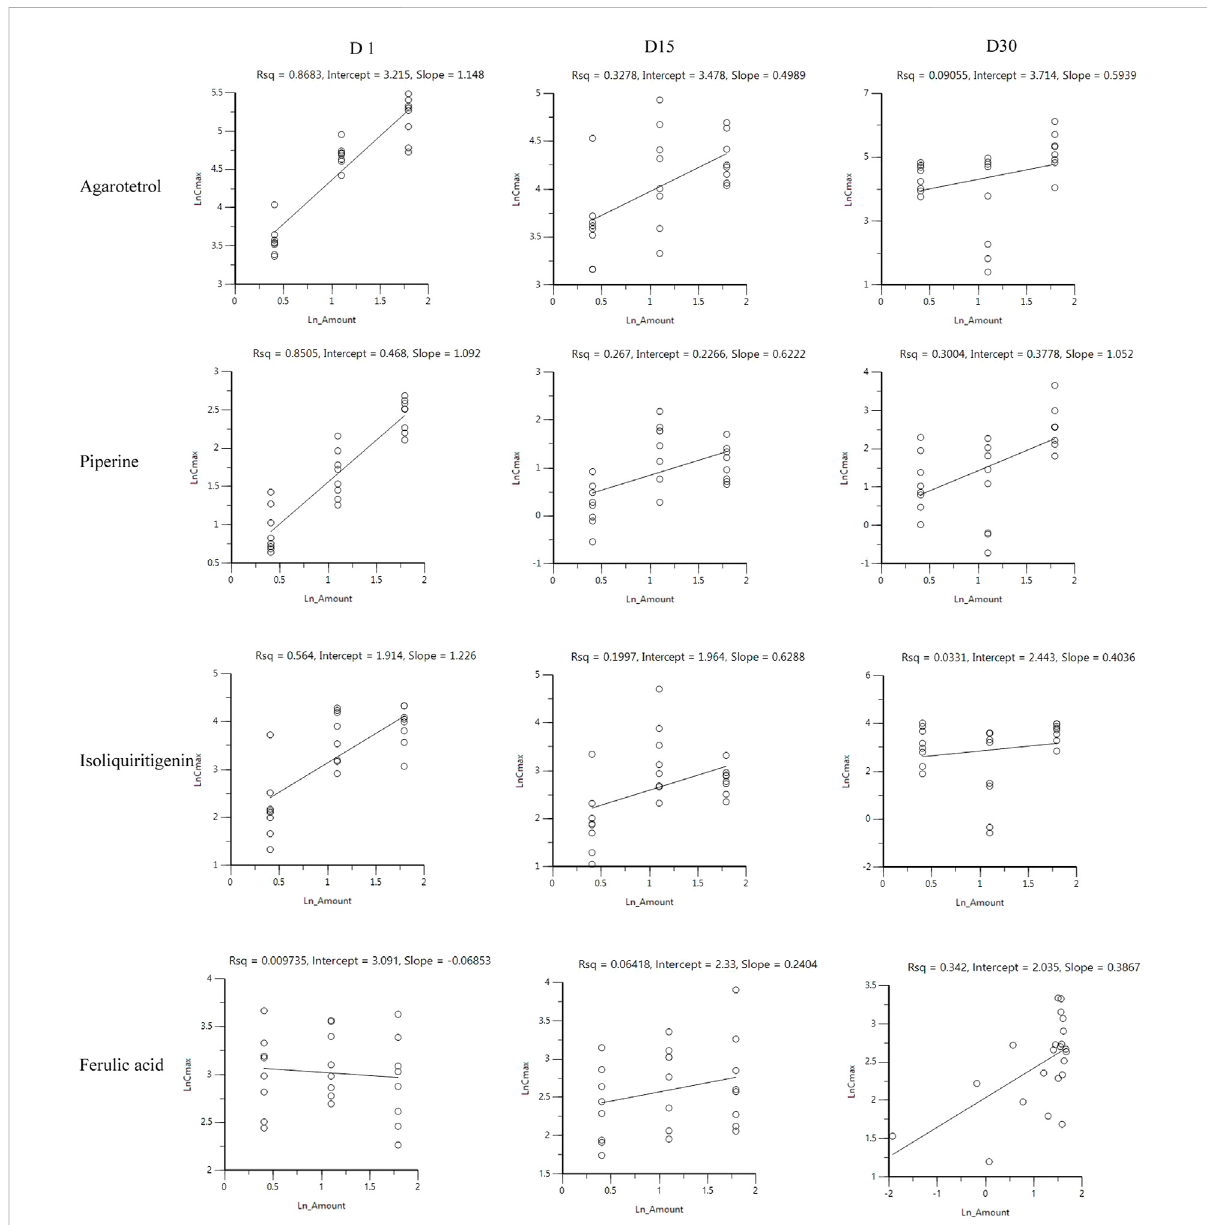
FIGURE 5 Linear relationship diagram between the logarithmic dose value and the logarithmic C max